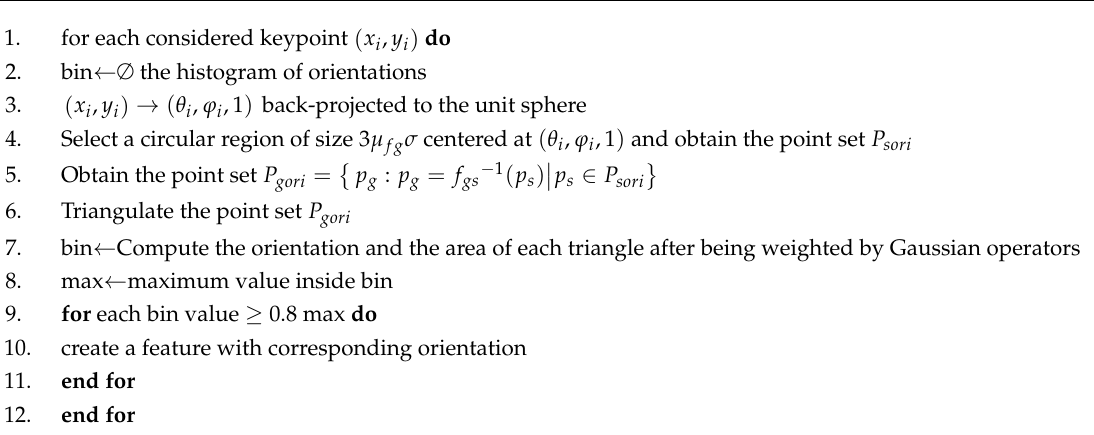
Algorithm 1 Algorithm for the computation of the dominant